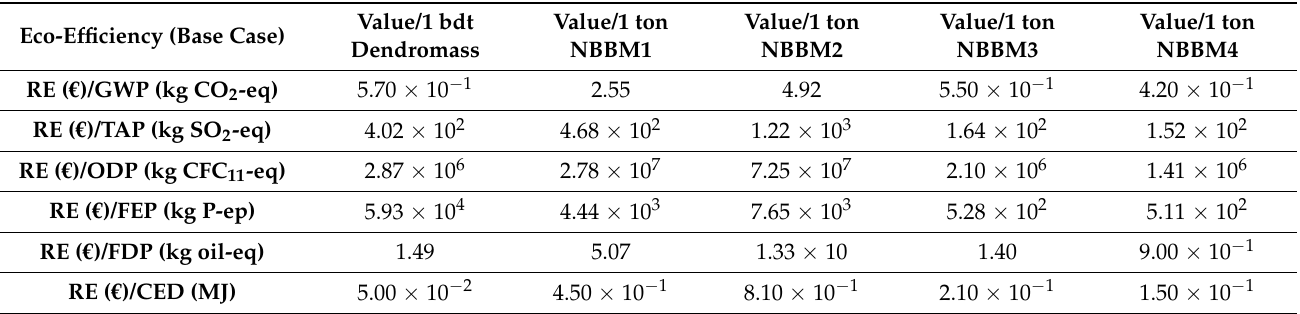
Table 5. Eco-efficiency based on revenue of the production of dendromass and NBBM1–4 per ton of product (Base Case).